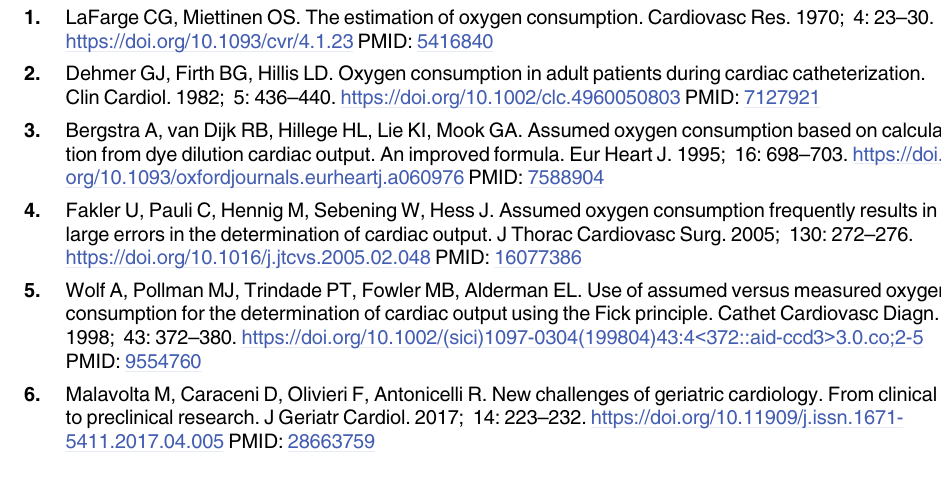
S8 Table. Comparison of advantages and disadvantages of cardiac output measurements methods. Abbreviations: eFM denominates estimated Fick method; CO, cardiac output; dFM, direct Fick method; TD, thermodilution method and 3D-TEE, three-dimensional